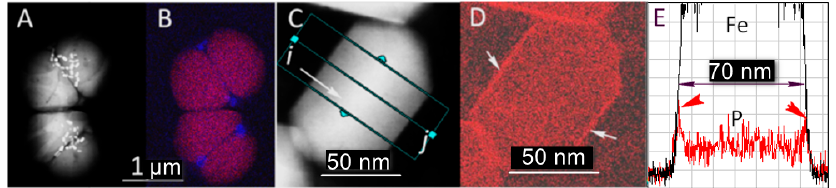
Figure 1. Morphology and chemical map of some representative parts of the analyzed specimen. ( A ) Dark-field image of two adjacent bacteria. ( B ) Superposition of chemical maps of P (red) and S (blue). ( C ) High-resolution image of a crystal with near-perfect morphology. The green rectangle is the area of accumulation of the K α signal of the P from i to j, in order to obtain the graph ( E ). ( D ) Map of P. The white arrows indicate the presence of P on the contour of the crystal. ( E ) Spatial variation of the intensity collected from i to j. In red, the intensity of P, which has a peak within the region delimited by red arrows, corresponding to the localization of iron (in black).